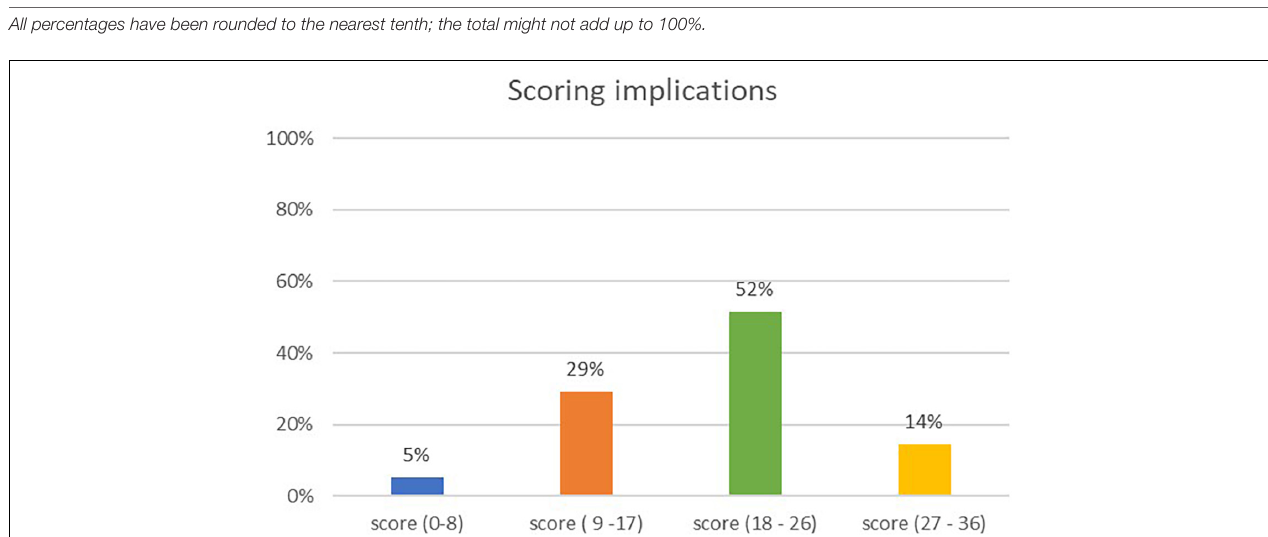
FIGURE 1 | Social accountability status based on the categorized scores. (0–8) Start a conversation with your classmates and school to begin to build SA at your school (9–17), your school has some SA strategies, look for ways to advocate to build on these existing strategies (18–26), your school is doing well, look for